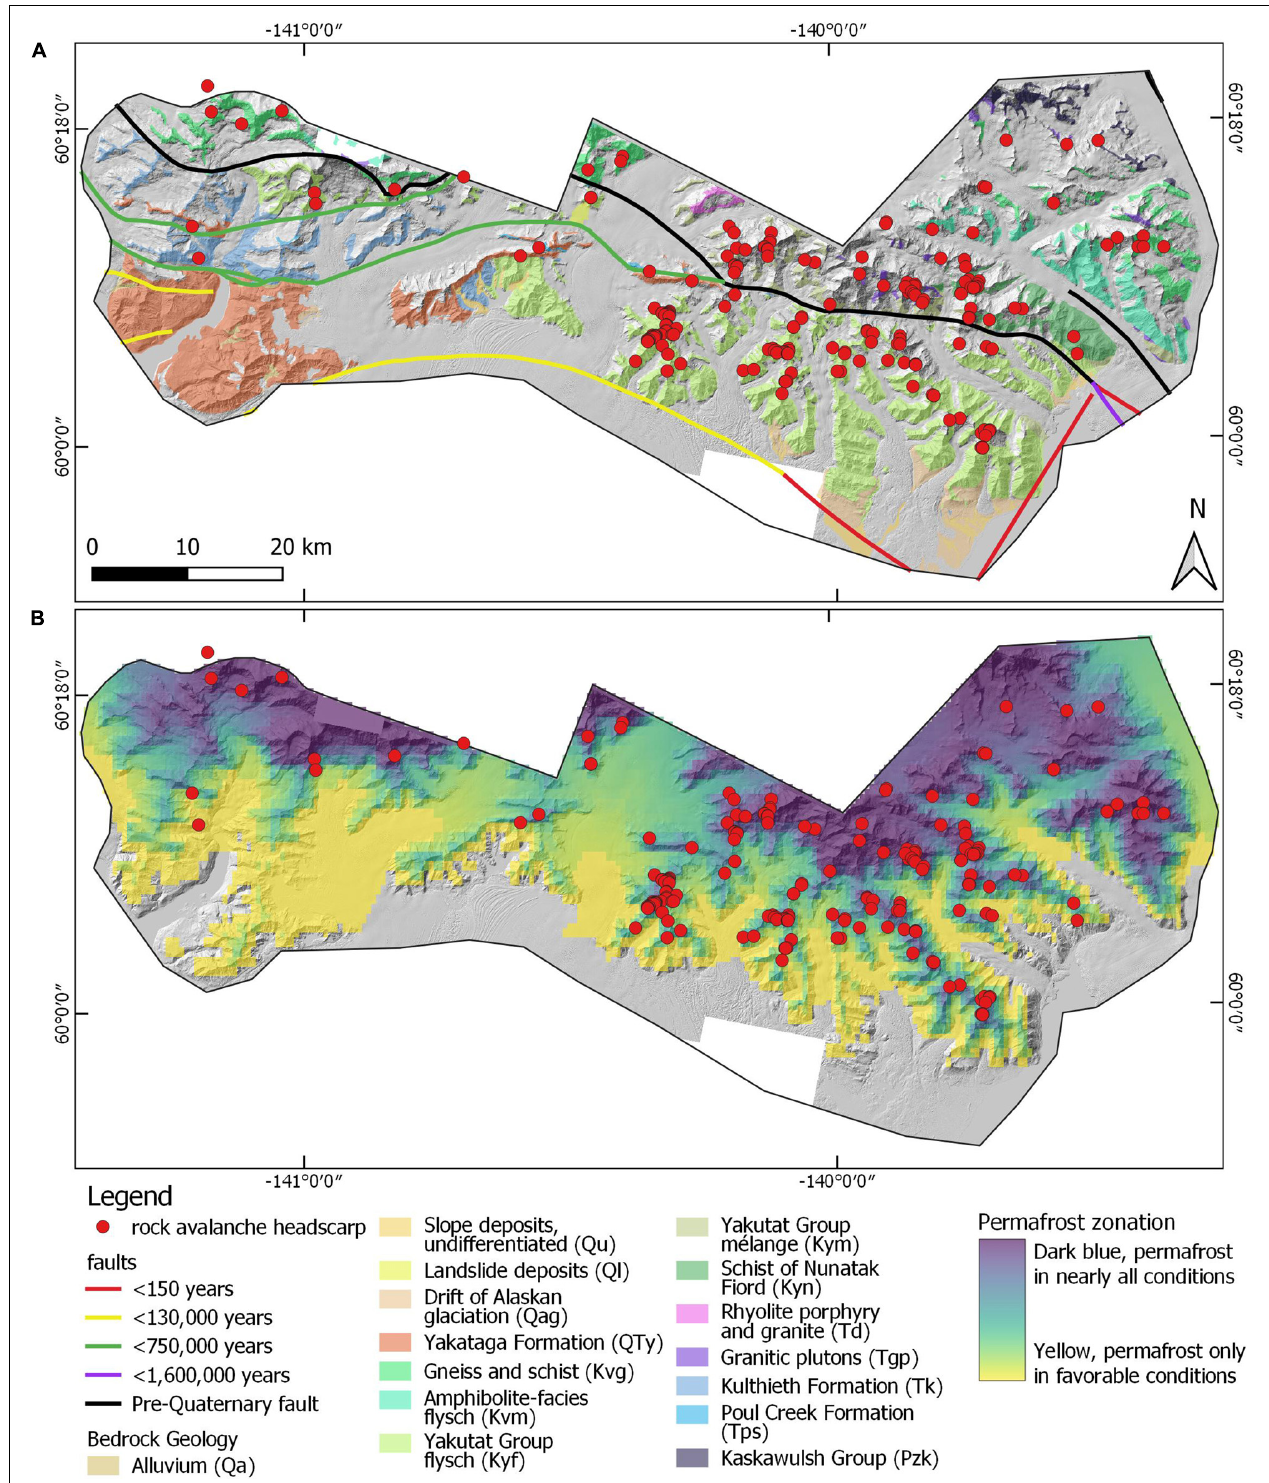
FIGURE 5 | (A) Map of the Saint Elias study area showing mapped rock avalanches, bedrock geology (Richter et al., 2005; Wilson et al., 2005) and fault locations (Koehler et al., 2012). Timing of most recent movement for each fault is shown. Geologic units have not been mapped in ice-covered areas, which account for ∼ 68% of the study area. (B) Permafrost zonation map (Gruber, 2012b) of the Saint Elias study area showing the locations of rock avalanches that occurred between 1984 and 2019.